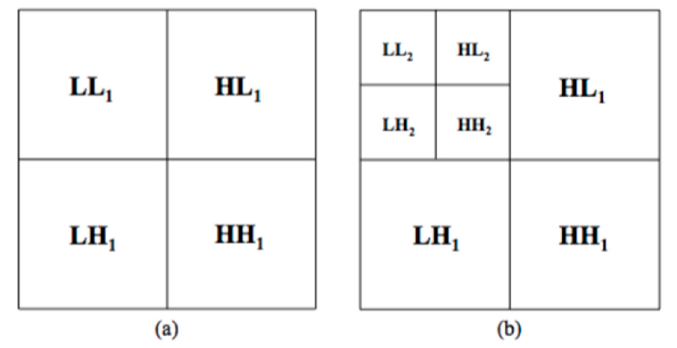
Figure 4. Haar decomposition: (a) first level and (b) second level decomposition. Finally, the GLCM set is formed by a total of 312 features, which represent the spatial relationship that on average links the gray levels of the image to each other.